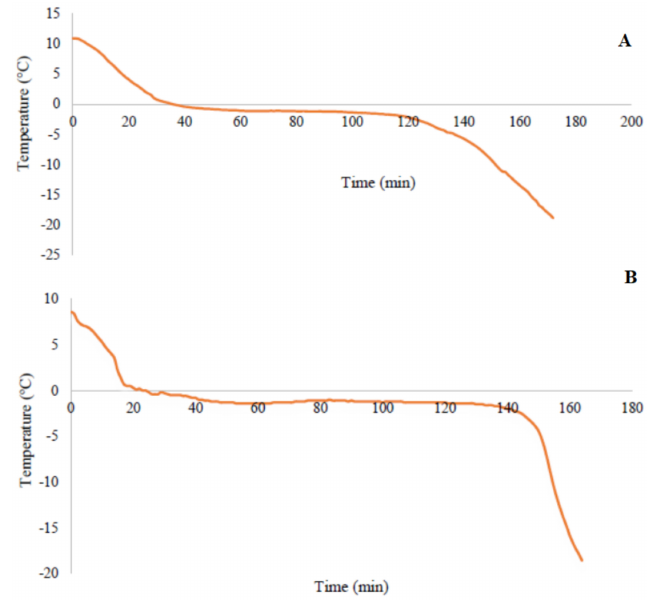
Figure 1. Freezing curves for the aqueous maqui ( A ) and calafate ( B ) extracts.